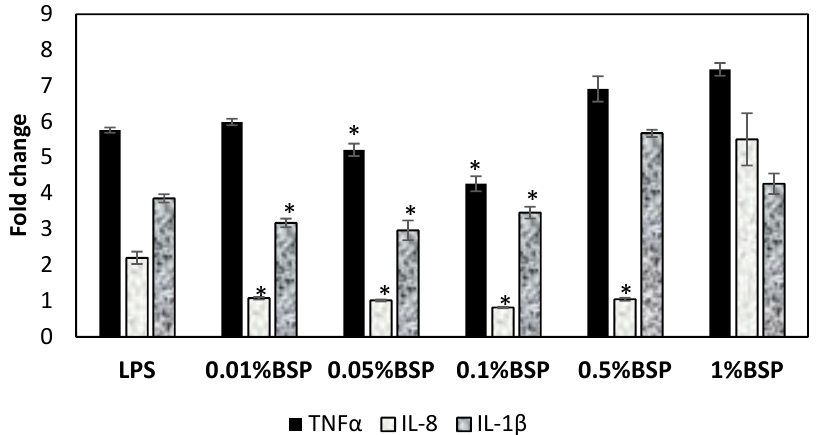
Figure 6. Expressions of inflammatory cytokine (TNF) α , IL8 and IL1 β in lipopolysaccharide (LPS)-induced HCEC following different concentrations of BSP treatment. Cells not treated with LPS were used as controls. (n = 3), *p < 0.05 compared to LPS group by one-way ANOVA.